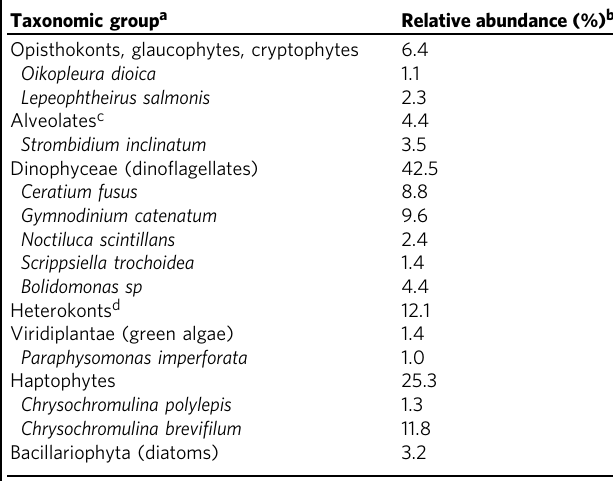
Table 1 Relative abundance of DGAT1 transcripts in the